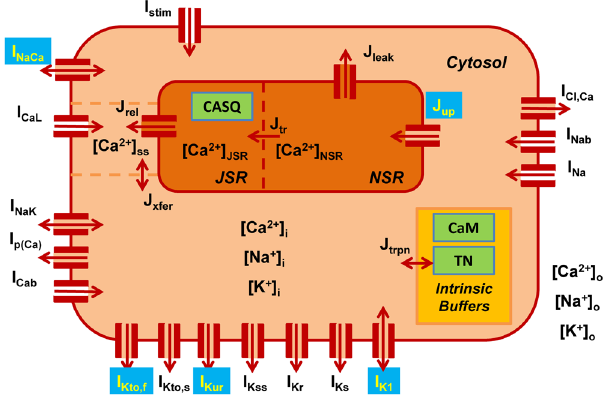
Figure 1. Schematic diagram of the mouse ventricular myocyte model that includes ionic currents and Ca 2 + fluxes. Transmembrane currents are: I Na , the fast Na + current, I CaL , the L-type Ca 2 + current, I p(Ca) , the sarcolemmal Ca 2 + pump, I NaCa , the Na + -Ca 2 + exchanger, I Kto,f , the rapidly recovering transient outward K + current, I Kto,s , the slowly recovering transient outward K + current, I Kr , the rapid delayed-rectifier K + current, I Kur , the ultra-rapidly activating delayed-rectifier K + current, I Kss , the non-inactivating steady-state voltage activated K + current, I K1 , the time-independent K + current, I Ks , the slow delayed-rectifier K + current, I NaK , the Na + -K + pump, I Cl,Ca , the Ca 2 + -activated chloride current, I Cab and I Nab , the Ca 2 + and Na + background currents. I stim is the external stimulation current. The Ca 2 + fluxes within the cell are: J up (uptake Ca 2 + from the cytosol to the network SR), J rel (Ca 2 + release from the junctional SR), J tr (Ca 2 + flux from the network to junctional SR), J leak (Ca 2 + leak from the SR to the cytosol), J xfer (Ca 2 + flux from the subspace volume to the bulk myoplasm), J trpn (Ca 2 + flux to troponin). The model also includes Ca 2 + buffering by troponin and calmodulin in the cytosol and by calsequestrin in the SR. The differences between WT and TG mice are highlighted in light blue color. They include I Kto,f , I Kur , I NaCa , J up , and I K1 (See details in Supplementary Table